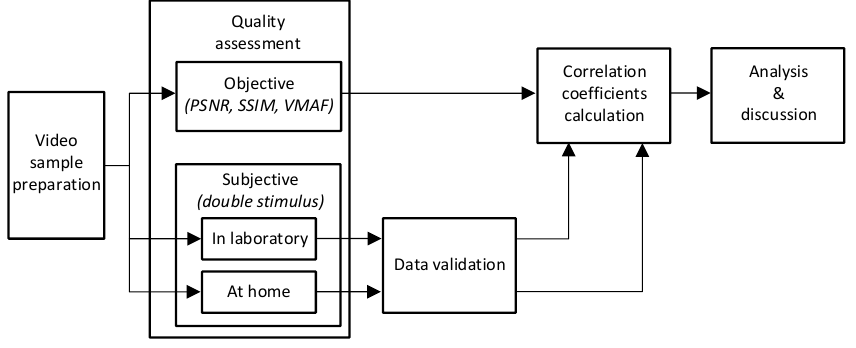
Figure 4. Flow diagram of the work.